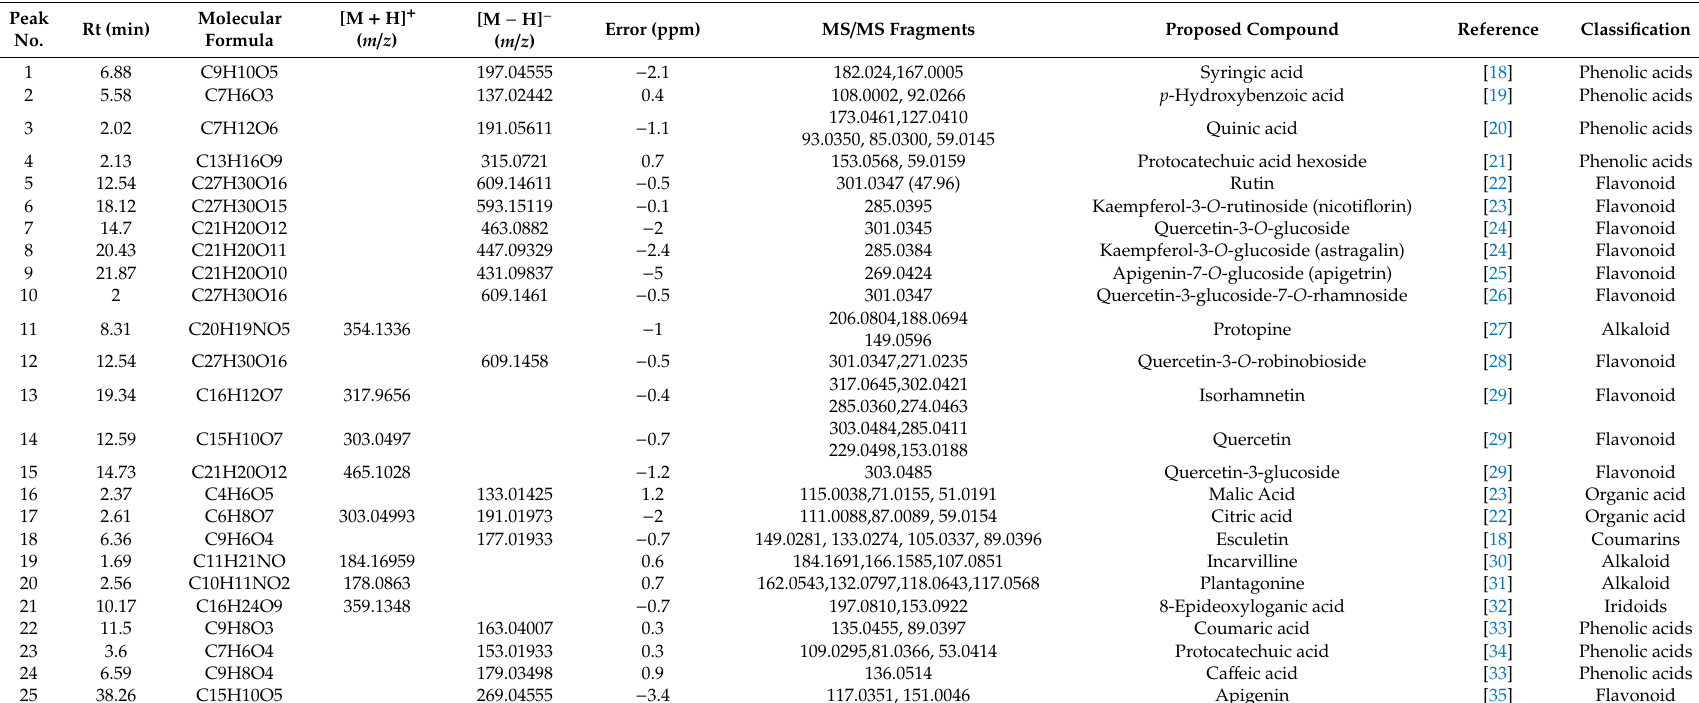
Table 2. Identification of the compounds in the mICM by